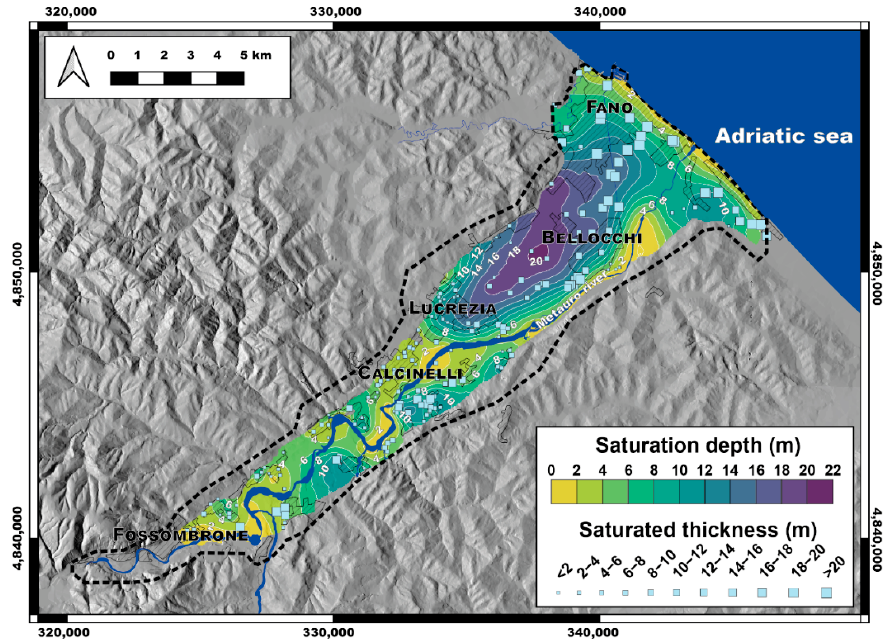
Figure 4. Saturation depth of the alluvial aquifer and saturated thickness of the sedimentary deposits.